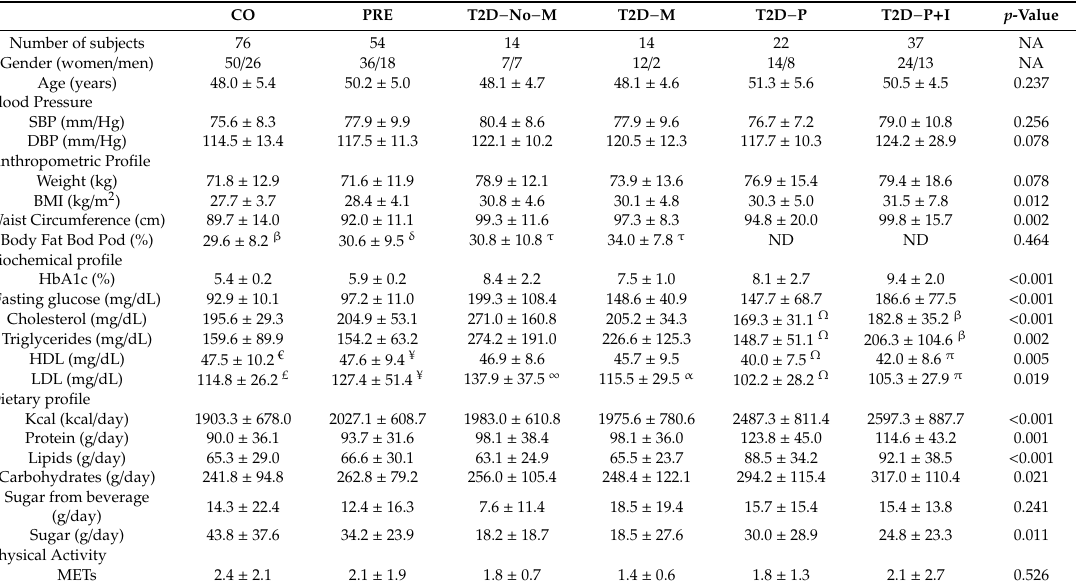
Table 1. General characteristics of the study